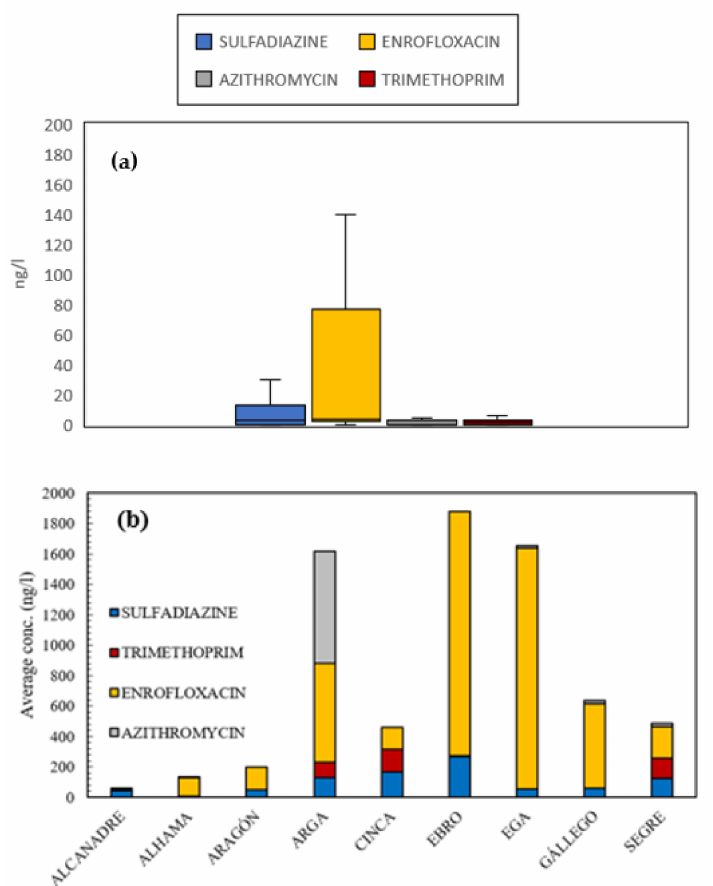
Figure 5. ( a ) Boxplots of selected antibiotics and ( b ) average concentration (ng/L) of target antibiotics among all surface-water-sampling points in the Ebro River basin area